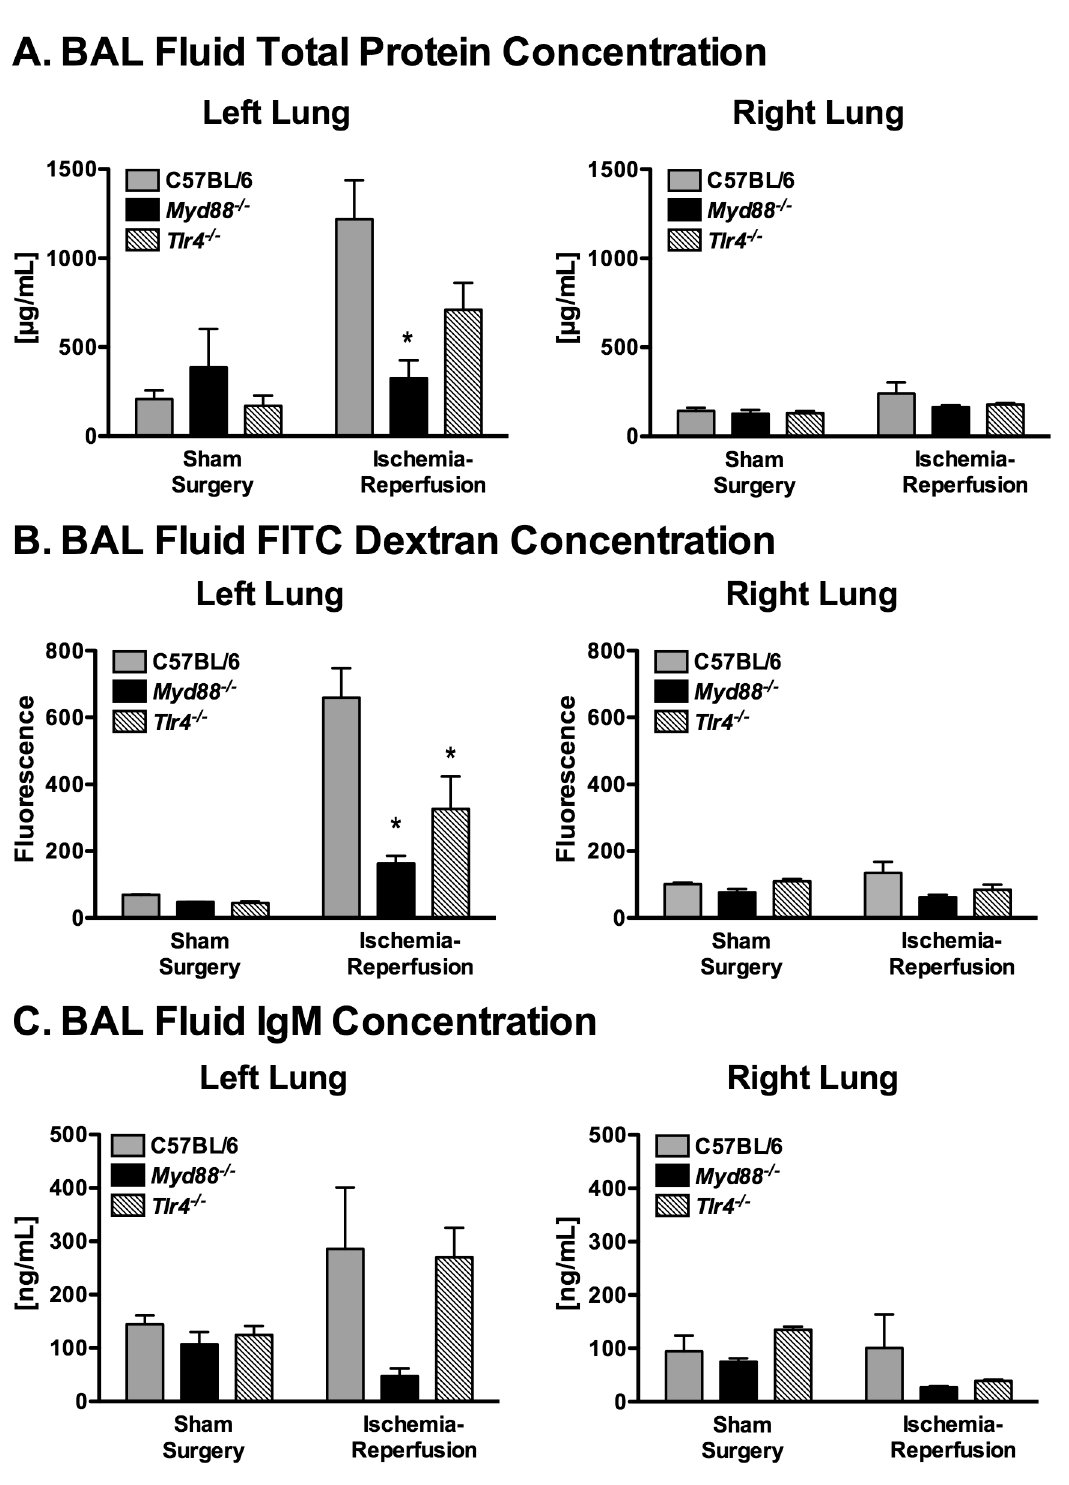
Figure 5. Lung permeability as measured by total protein (A), 70kD Dextran (B), and IgM (C) in bronchoalveolar lavage fluid. (n = 6/grp, *p ≤ 0.05 compared with C57BL/6 and, † p ≤ 0.05 compared with Tlr4 -/- ).